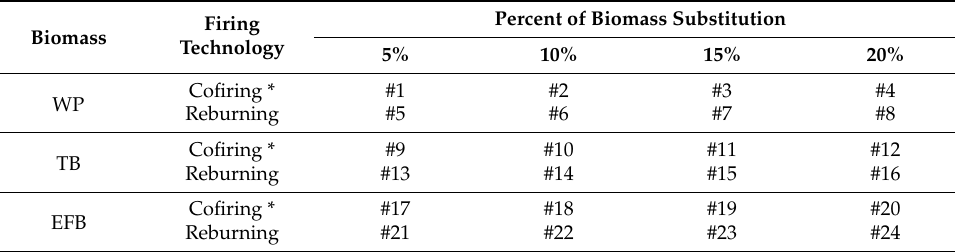
Figure 2. Experimental apparatus: ( a ) schematic diagram; ( b ) furnace dimensions (unit: mm). Table 1. Details of fuel substitution ratios and for all case numbers.